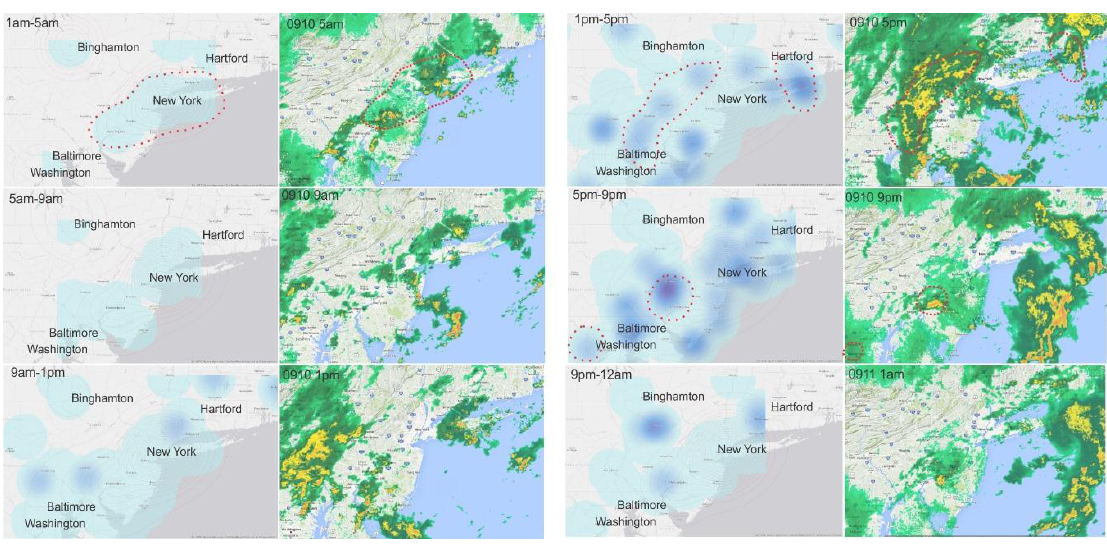
Figure 5. The spatial distributions of keywords about rain and the real-time cloud map in the study